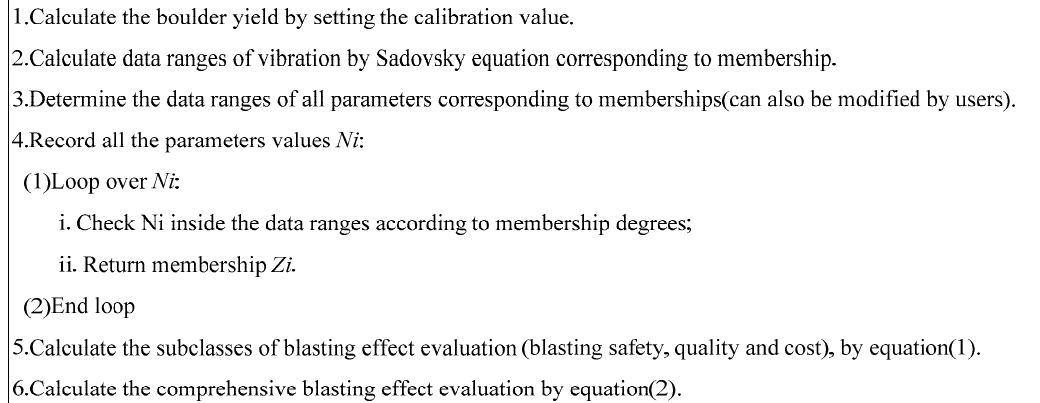
Figure 5. The algorithm of blasting effect evaluation.